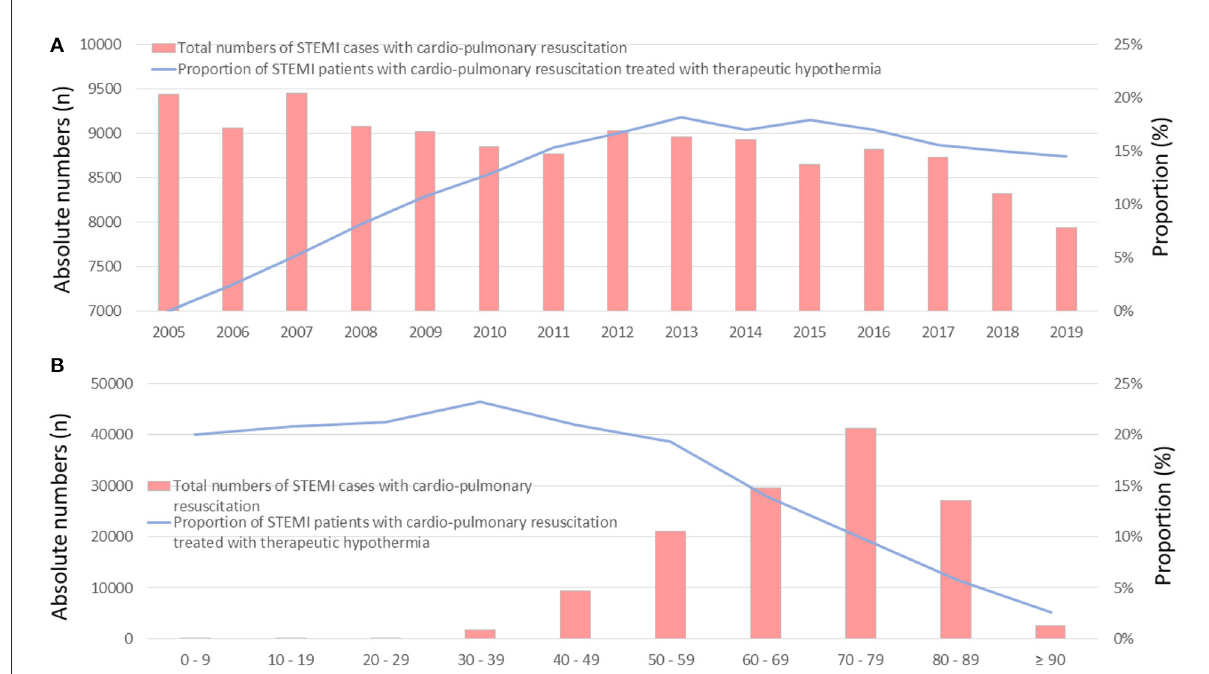
FIGURE1 Time trends of total numbers of STEMI patients with CPR (red bars), and the proportion of these patients treated with therapeutic hypothermia (blue line) (A) time trends stratified by treatment years (B) time trends stratified by age/decade of life.